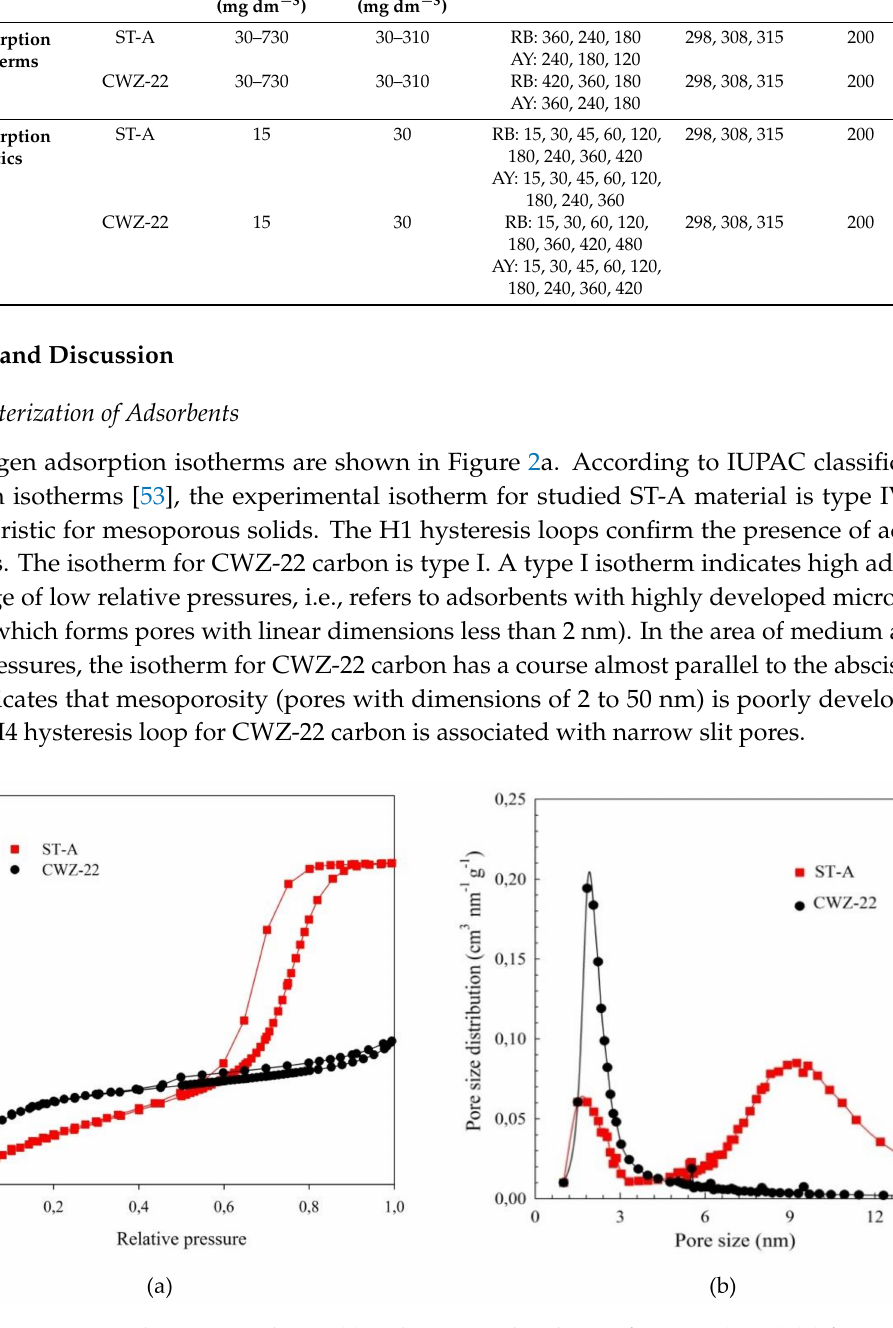
Figure 2. Nitrogen adsorption isotherms ( a ) and pore size distribution functions (PSDs) ( b ) for studied carbon